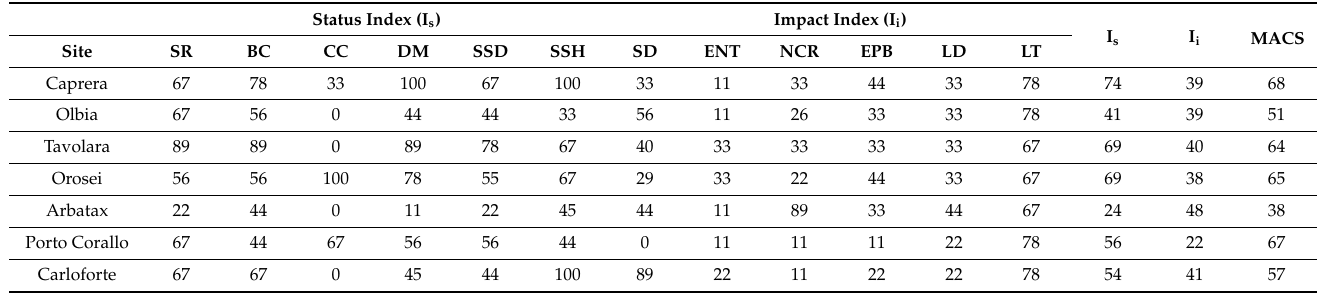
Table 1. Scores obtained for the 12 metrics, the Status Index, the Impact Index and the MACS Index in the 7 investigated